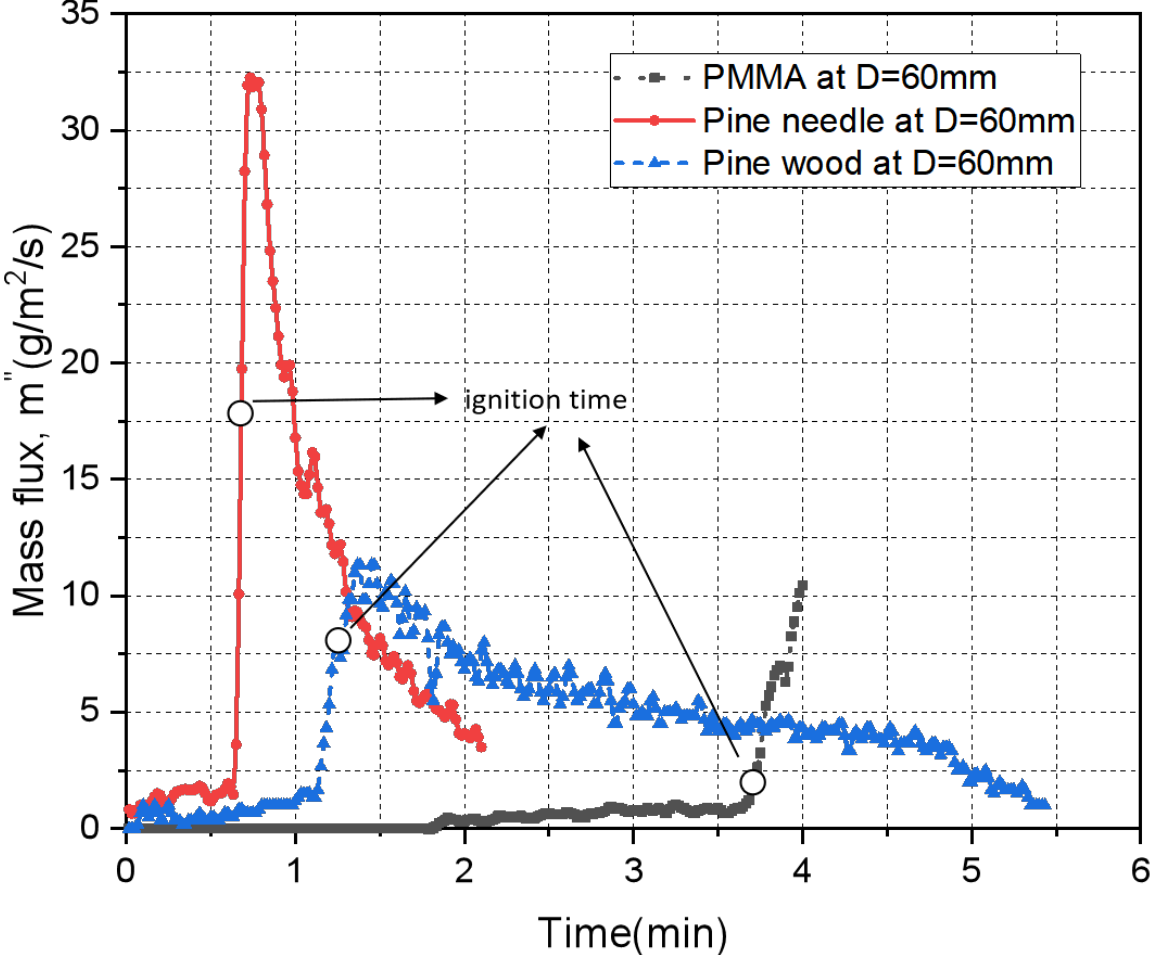
Figure 8. Time evolution of mass flux difference in the ignition process of different fuel types.